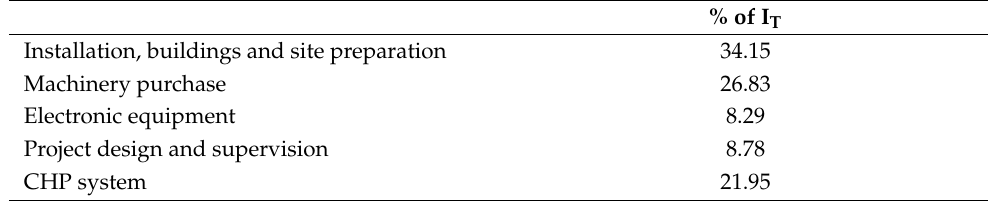
Table 7. Individual investment costs of the unit based on Standard Evaluation Sheet of CRES